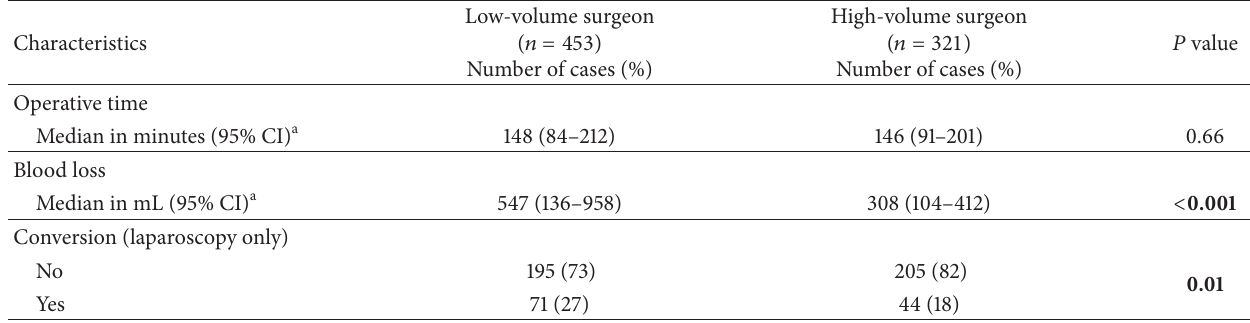
Table 2: Intraoperative characteristics.